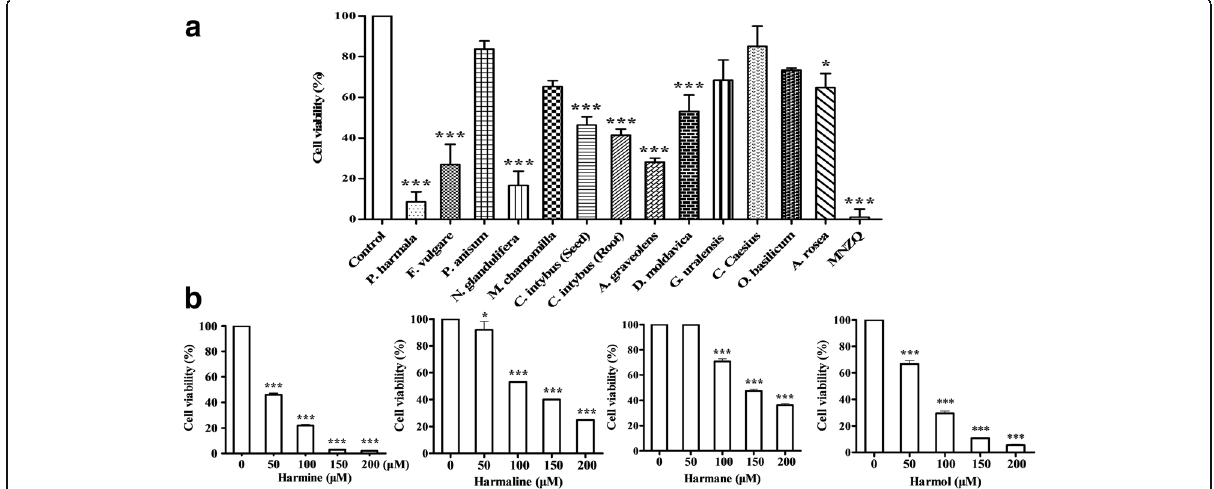
Fig. 2 The anti-melanoma effects of MNZQ, herb extracts and active ingredients on B16 cells assessed by CCK8. a: P. harmala : 1 mg/mL; F. vulgare : 4 mg/mL; P. anisum : 10 mg/mL; N. glandulifera : 2 mg/mL; M. chamomilla : 4 mg/mL; C. intybus (seed): 10 mg/mL; C. intybus (Root): 10 mg/mL; A. graveolens : 4 mg/mL; D. moldavica : 1 mg/mL; G. uralensis : 4 mg/mL; C. caesius : 4 mg/mL; O. basilicum : 5 mg/mL; A. rosea : 10 mg/mL; MNZQ: 60 mg/mL; b: active ingredients of harmine, harmaline, harmane, and harmol with concentration ranging from 50 to 200 μ M. Results are expressed as the mean±SD ( n =3). * P <0.05, *** P <0.001 vs. the control